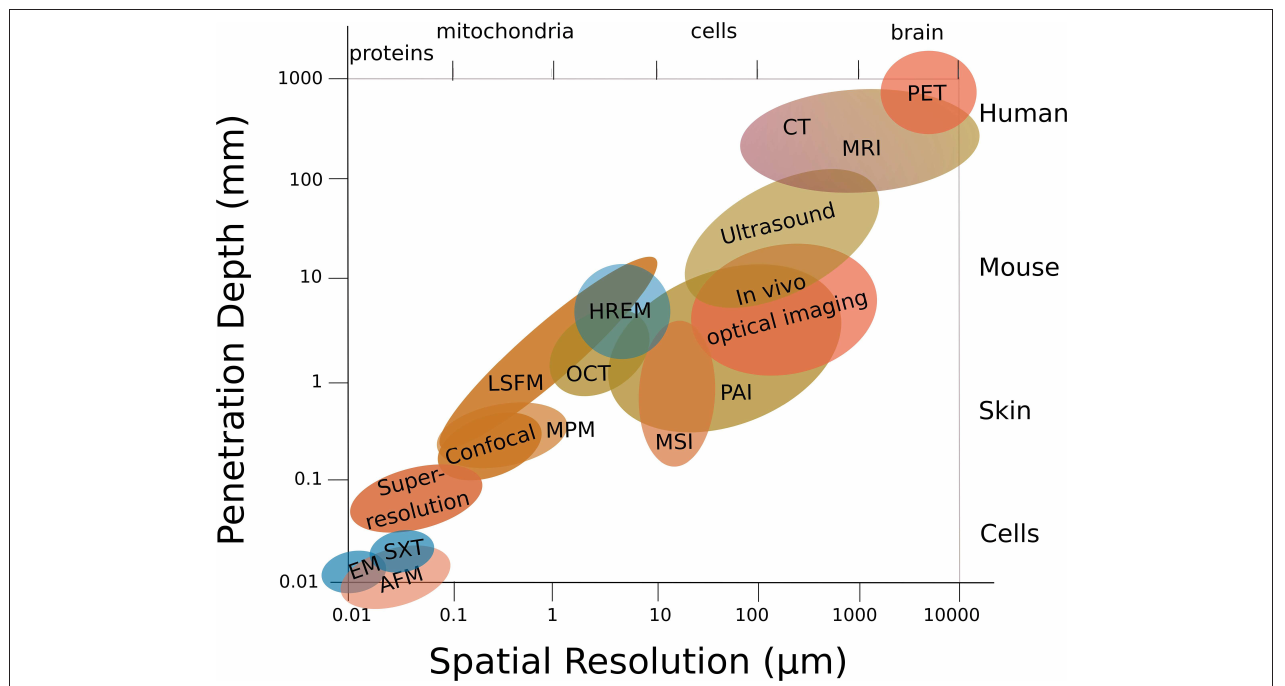
FIGURE 3 | Structural multiscale imaging. Penetration depth usually comes at the expense of lateral resolution. Same abbreviations as in Figure 1 .